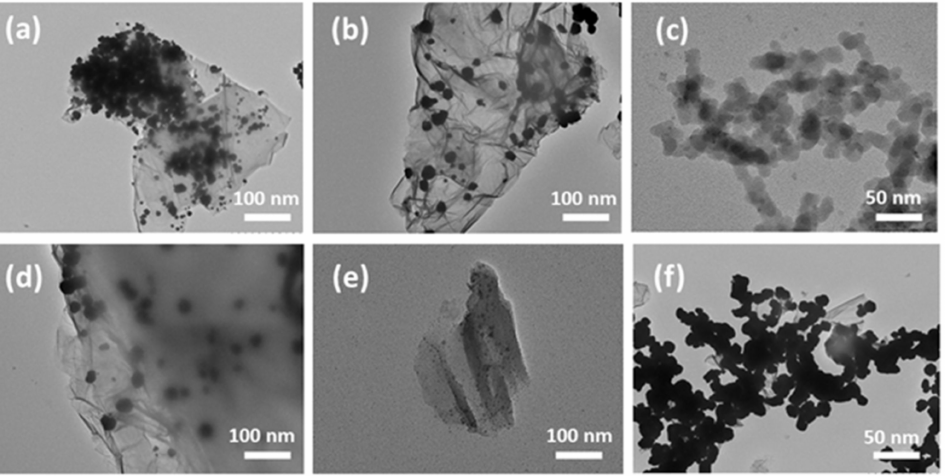
Figure 4. TEM images of the RGO/Cu/Cu 2 O composite in various parts of the